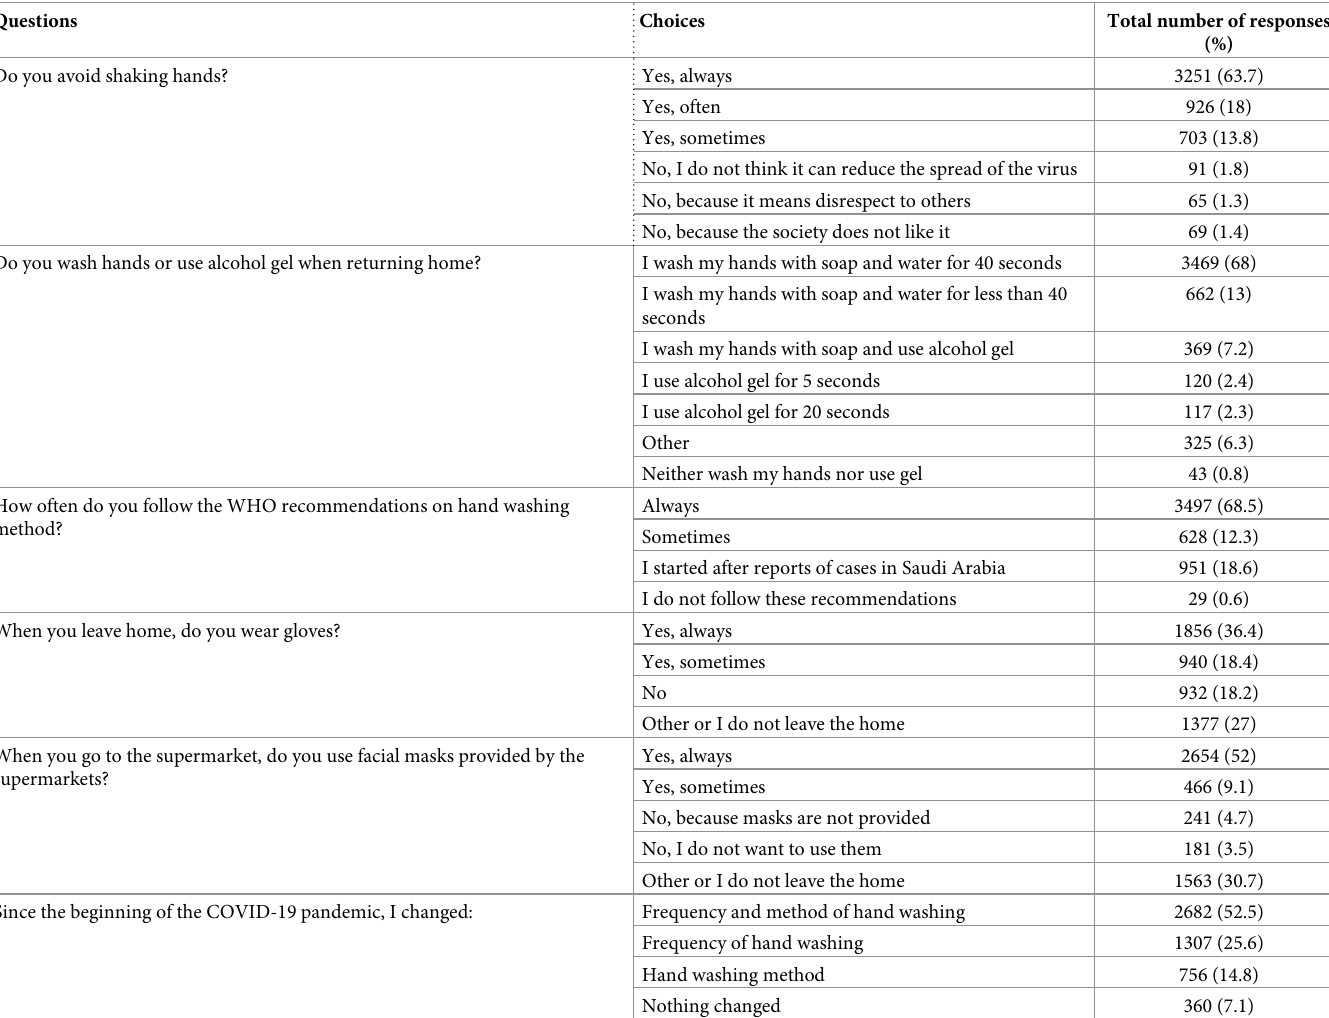
Table 6. Responses to questions assessing practice of Saudi population to the recommended protective methods during the COVID-19 pandemic.